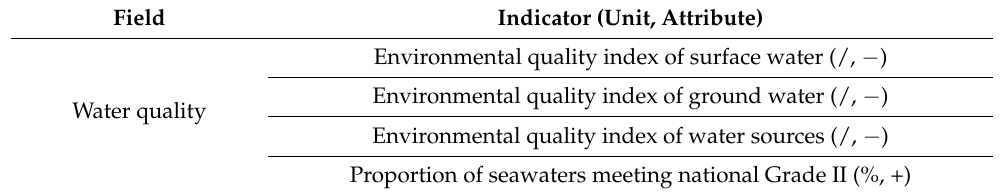
Table 2. The water sustainability indicators for city − level